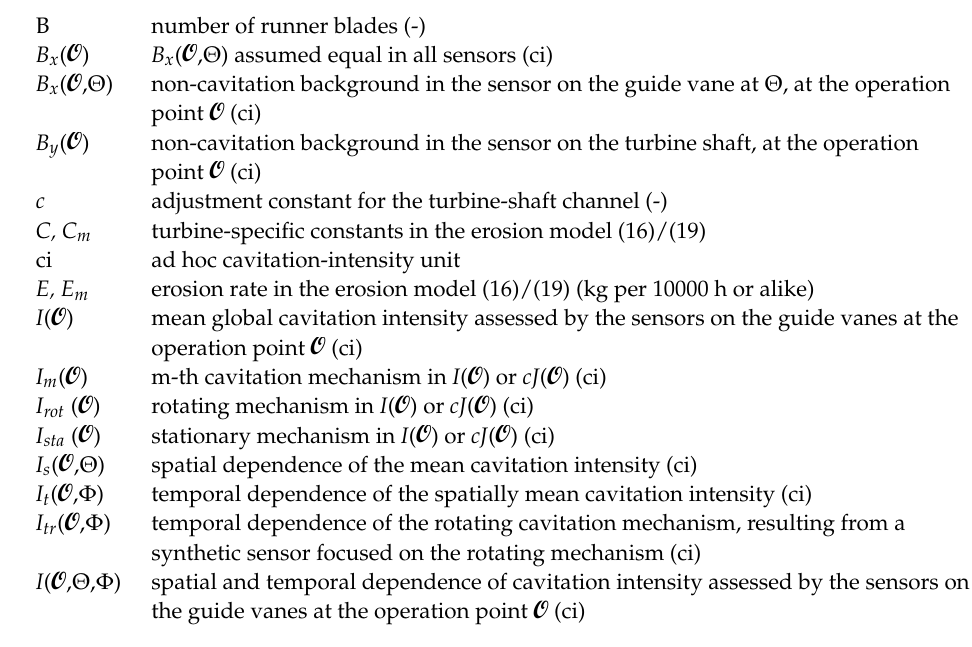
Figure 3. Front panel of the multidimensional data acquisition processor. The simplest description of cavitation comes out online after half an hour of measurement on the prototype. More compli- cated descriptions require days or weeks of recorded data analysis by a trained user.